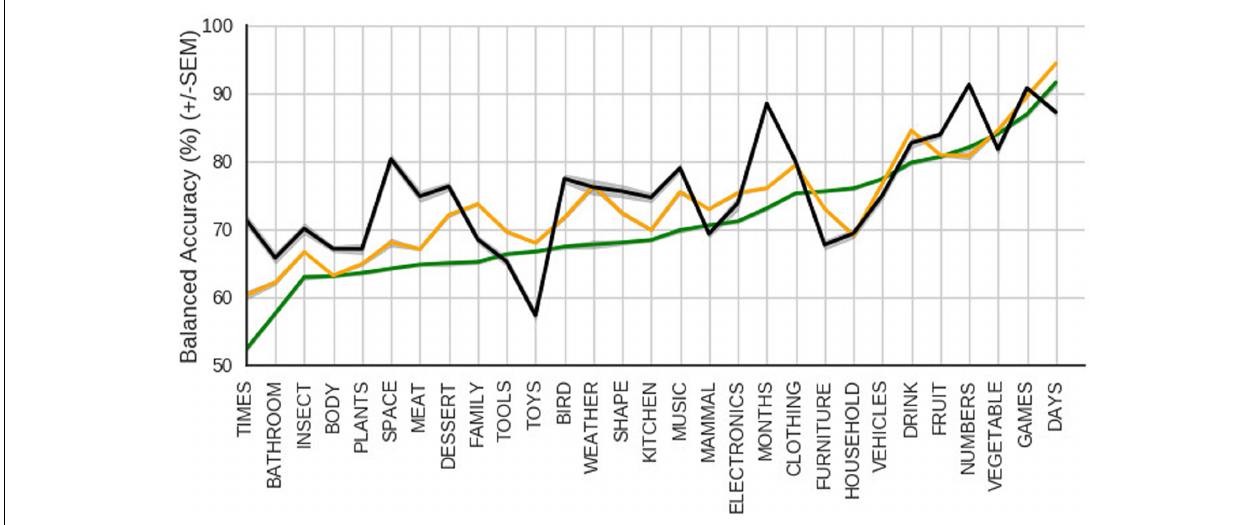
FIGURE 7 | Balanced accuracy when using a model’s similarity scores to judge whether two words belong to the same or to different categories. The gray area represents the standard error of the mean. Colors: LSTM (orange), SRN (green), and skip-gram (black).